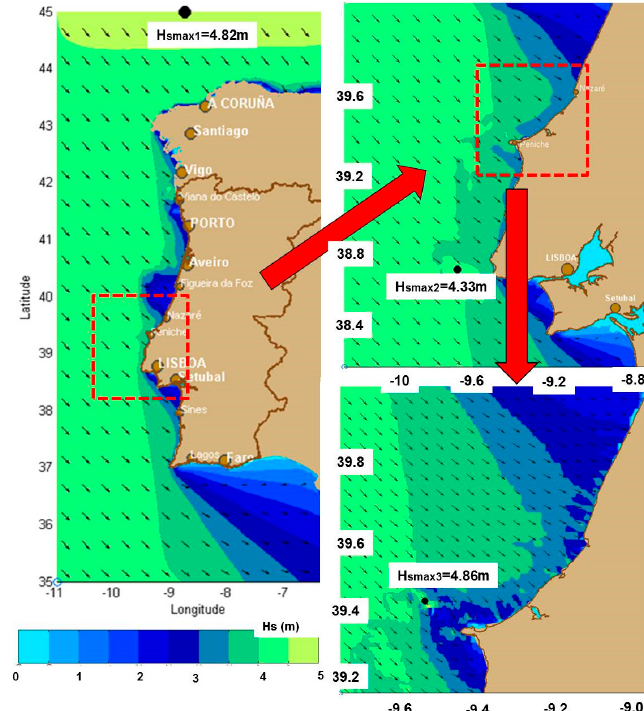
Figure 2. Example of the wave transformation in terms of significant wave height scalar fields and wave vectors in the first three computational levels considered. These are model system results for the time frame 2011/11/18/h21 corresponding to average to high winter time energy conditions.